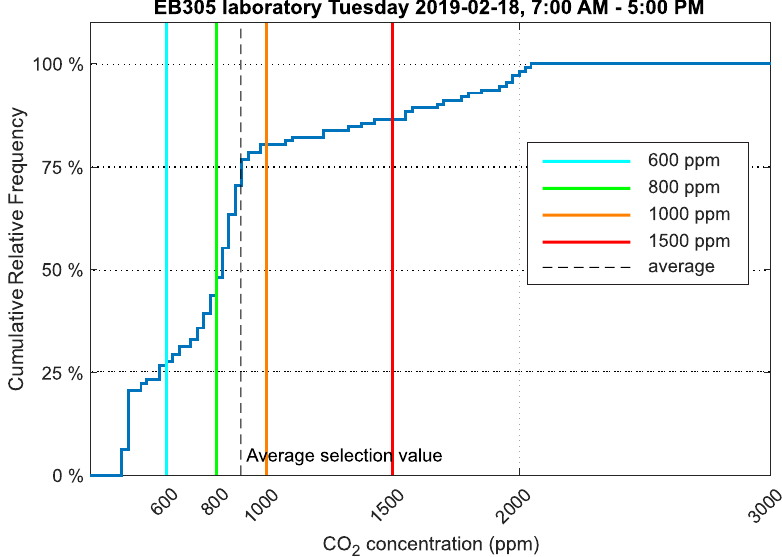
Figure 9. Cumulative relative frequency graph of the data selection showing CO 2 concentration in laboratory EB305,